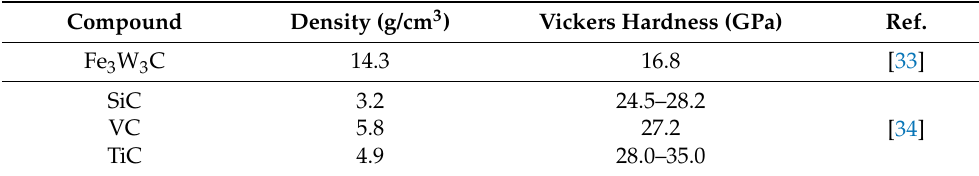
Table 6. The intrinsic characteristics of